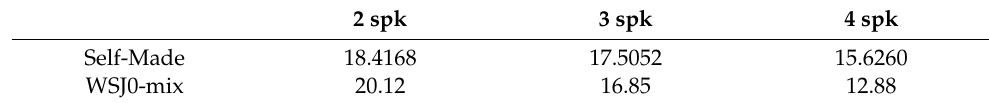
Table 1. SI-SNRi for different numbers of mixed speakers.